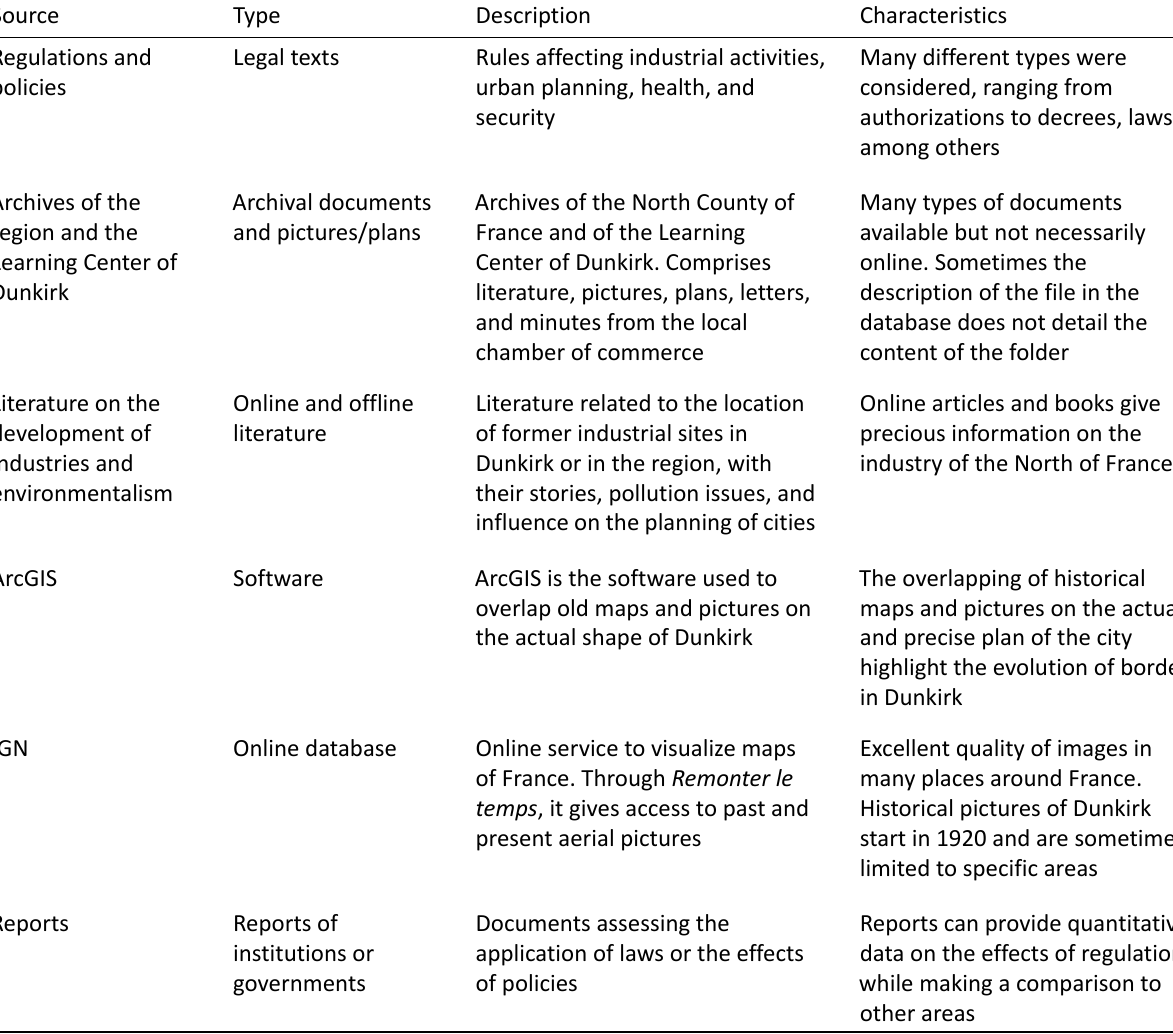
Table 1. A summary of the different materials used in this